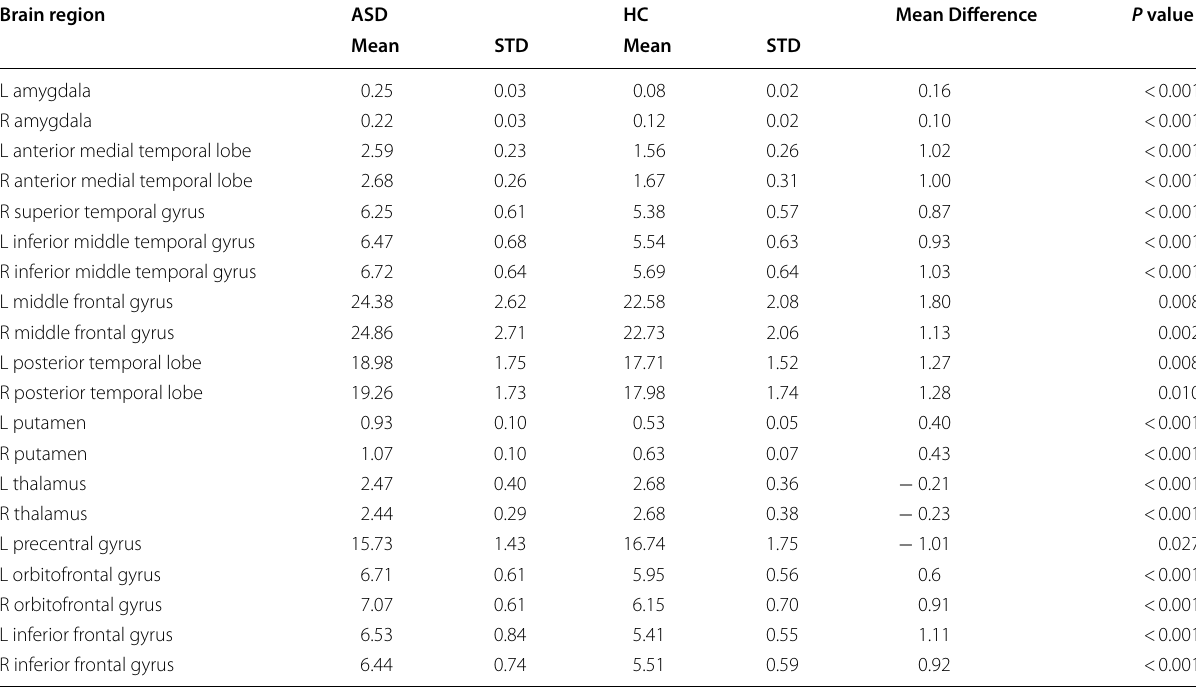
ASD Autism Spectrum Disorder, HC Healthy Controls, STD Standard Deviation, L Left, R Right